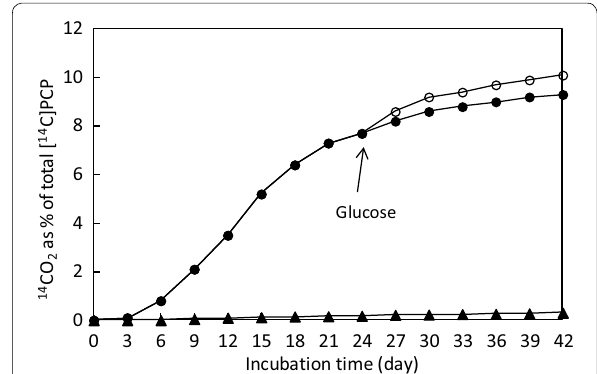
Fig. 4 Release of 14 CO 2 from [ 14 C]PCP in P. acanthocystis culture without glucose supplement ( closed circles ) and with glucose supplement ( open circles ) for 42 days. Release of 14 CO 2 from the sterilized cultures ( closed triangles ) is also shown. Values are mean SD of triplicate samples. The arrow represents addition of ± 10 g/L glucose at 24